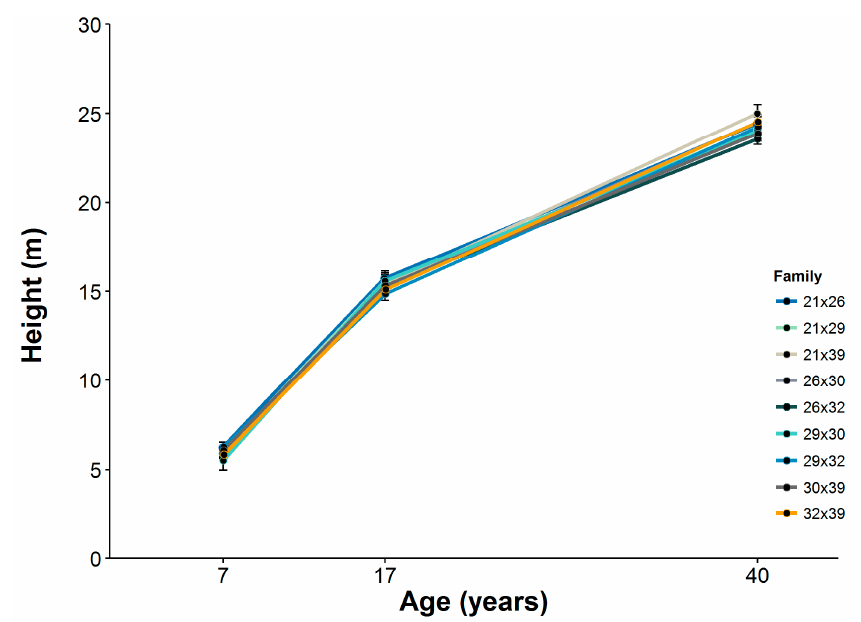
Figure 2. Family mean height at ages 7, 17 and 40. Vertical lines for each data point represent the standard error of the mean.